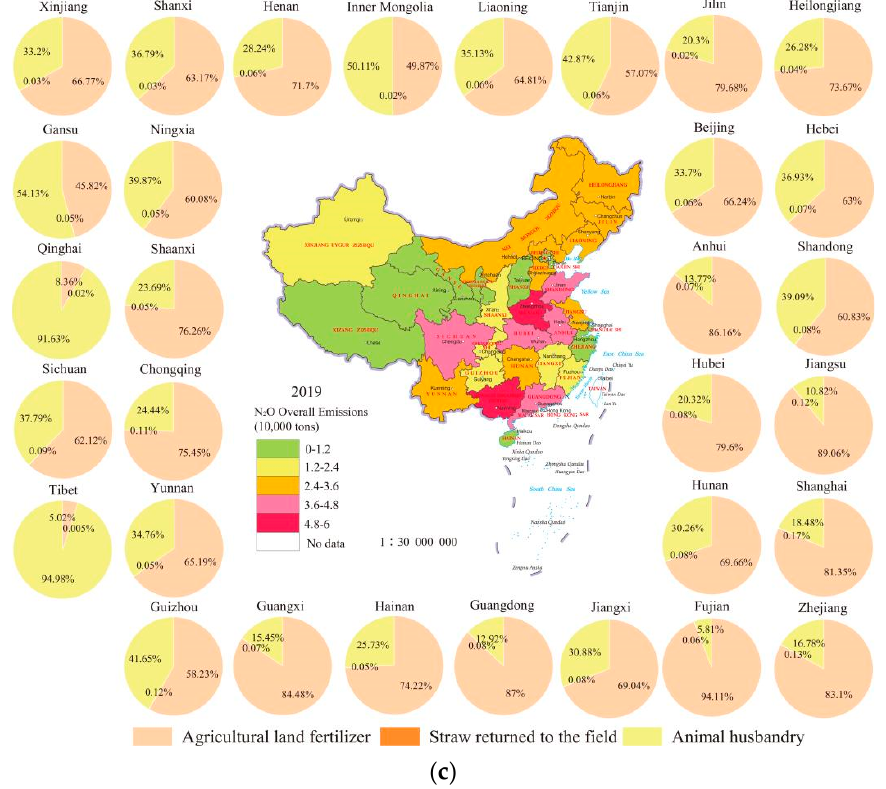
Figure 3. Provincial N 2 O Emissions from 2000–2019 in China (( a ) 2000; ( b ) 2010; ( c ) 2019). N 2 O emissions from each part showed the characteristics of regional